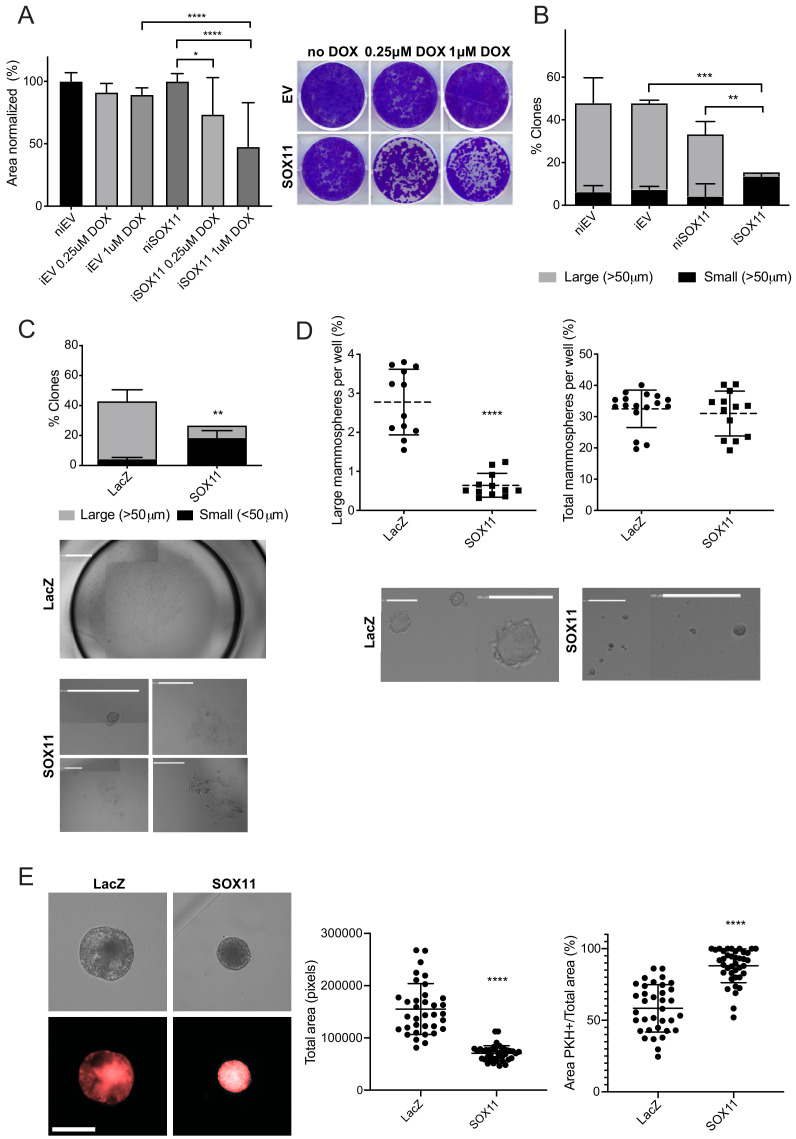
Inducible expression of SOX11 in DCIS.com cells leads to changes in stem cell activity.(A) Representative colony-forming assay results using niEV, iEV, niSOX11 and iSOX11 cells. The area stained with crystal violet was quantified and normalised by the area of niEV or niSOX11, respectively. Representative photo is shown. Experiment was performed thrice with three replicates each. (B) Percentage of iEV and iSOX11 cells plated in two‐dimensional (2D) culture that form colonies. Cells were sorted by FACS and single cells were plated per well in a 96-well. Results are shown as the % of clones obtained divided by the cells seeded in each cell line. Experiment was performed twice with 30 cells for each cell line. (C) Percentage of DCIS-LacZ and DCIS-SOX11 cells plated in two‐dimensional (2D) culture that form colonies. Cells were sorted by FACS sorted and single cells were plated per well in a 96-well. Results are shown as the % of clones obtained divided by the cells seeded in each cell line. Experiment was performed thrice with 30 cells for each cell line. Typical morphologies observed for DCIS-LacZ and DCIS-SOX11 clones are shown. (D) Quantification of sphere-initiating capacity of DCIS-LacZ and DCIS-SOX11 cells plated in three‐dimensional (3D) culture that form spheres grown in methylcellulose and ultra-low attachment plates. Results are shown as the % of clones larger than 50 µm (upper graph) or as a percentage of total clones (down) obtained divided by the cells seeded in each cell line. Experiments were performed twice with six biological replicates each. 10,000 cells were plated per well. Typical morphologies observed for spheroid formed from DCIS-lacZ and DCIS-SOX11 cells grown in methylcellulose and ultra-low attachment plates. (E) Representative images showing PKH26 dye labelling of DCIS-lacZ and DCIS-SOX11 spheres grown in ultra-low attachment 96-well plates after 14 days. Graphs represent the size of the spheres formed (pixel2) and the percentage of the area that is PKH+ in each sphere. Experiment was replicated twice (n = 35).